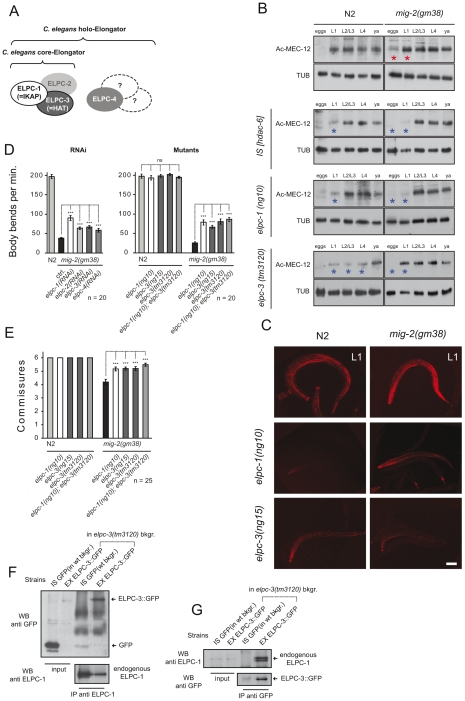
The elongator is required for acetylation of MEC-12/α-tubulin.(A) C. elegans elongator based on sequence comparison. (B) Western blot analyses of MEC-12/α-tubulin acetylation. Developmental stages of worms are indicated. Total α-tubulin (using AB directed against all α-tubulins in C. elegans) served as loading control. Left panels: wt (N2), HDAC-6 overexpression or elongator deletion mutations as indicated. Right panels: corresponding situation in the mig-2(gf) background. Comparative western blots of all strains to wt (N2) and mig-2(gm38) were carried out to calibrate the acetylation intensities, representative blots for each strain are shown. (C) Confocal micrographs of whole mount staining of acetylated MEC-12/α-tubulin in L1 larvae of different genetic backgrounds. The strongest signal is attributed to the axons of touch neurons and sensory cilia at the nose tip. Acetylation of MEC-12/α-tubulin is diminished in elongator mutants as compared to wt (N2) and suppresses the hyperacetylation of mig-2(gm38) mutants. Bar 15 µm. (D) Body bends per minute showing the suppression of mig-2(gm38) by elongator knock down by RNAi or elongator mutants. (E) Average commissures per L1 animal in different mutant backgrounds showing the suppression of the defects in mig-2(gm38) by elongator mutants. (F) CoIP of ELPC-3::GFP with endogenous ELPC-1 in elpc-3(tm3120) mutants or in GFP-expressing wt strains (unc-25::gfp) as a control. ELPC-1 was immunoprecipitated from protein lysates and immunoblotted with an anti-GFP antibody to detect co-precipitating ELPC-3::GFP. Inputs (1/50 of total immunoprecipitated lysate) of ELPC-3::GFP and GFP alone are shown on the left (upper panel). In the lower panel, the blot with anti-ELPC-1 antibody detects the total amount of immunoprecipitated ELPC-1. (G) Reciprocal CoIP to (F) using anti-GFP antibody for IP and anti ELPC-1 antibody for WB. P values: ns = not significant; ***<0,001. Error bars: SEM.